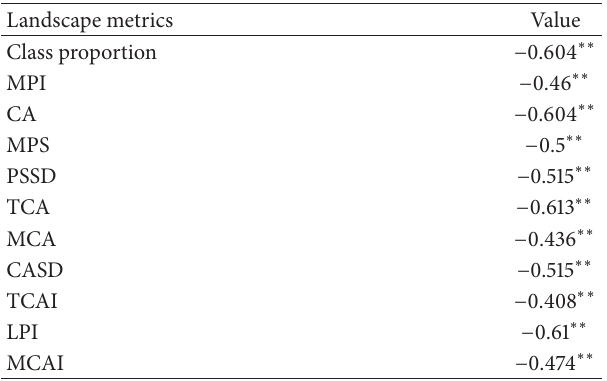
Table 2: Pearson’s correlation coefficient between landscape metrics of water and LST.